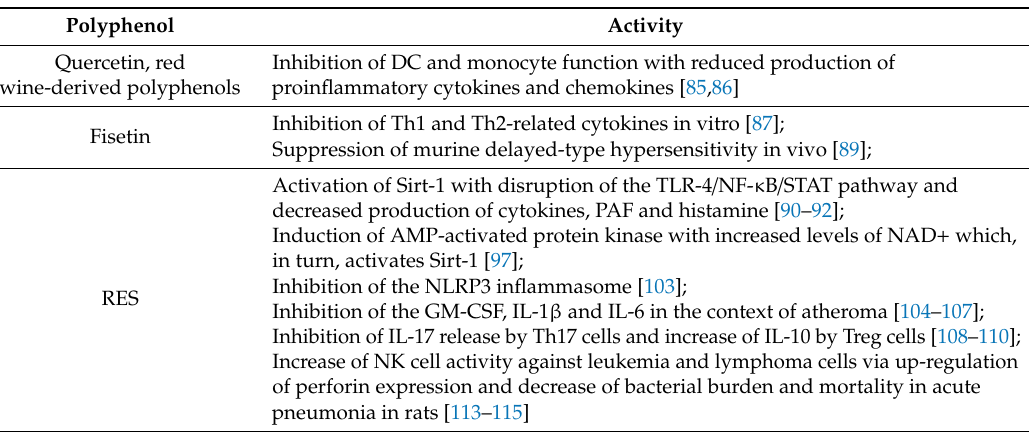
Table 2. Red grape polyphenol-induced